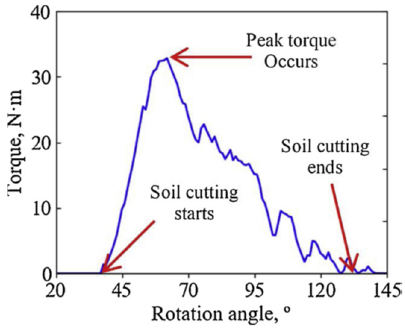
Figure 4. Typical torque variation curve during rotary tillage soil cutting process [132].